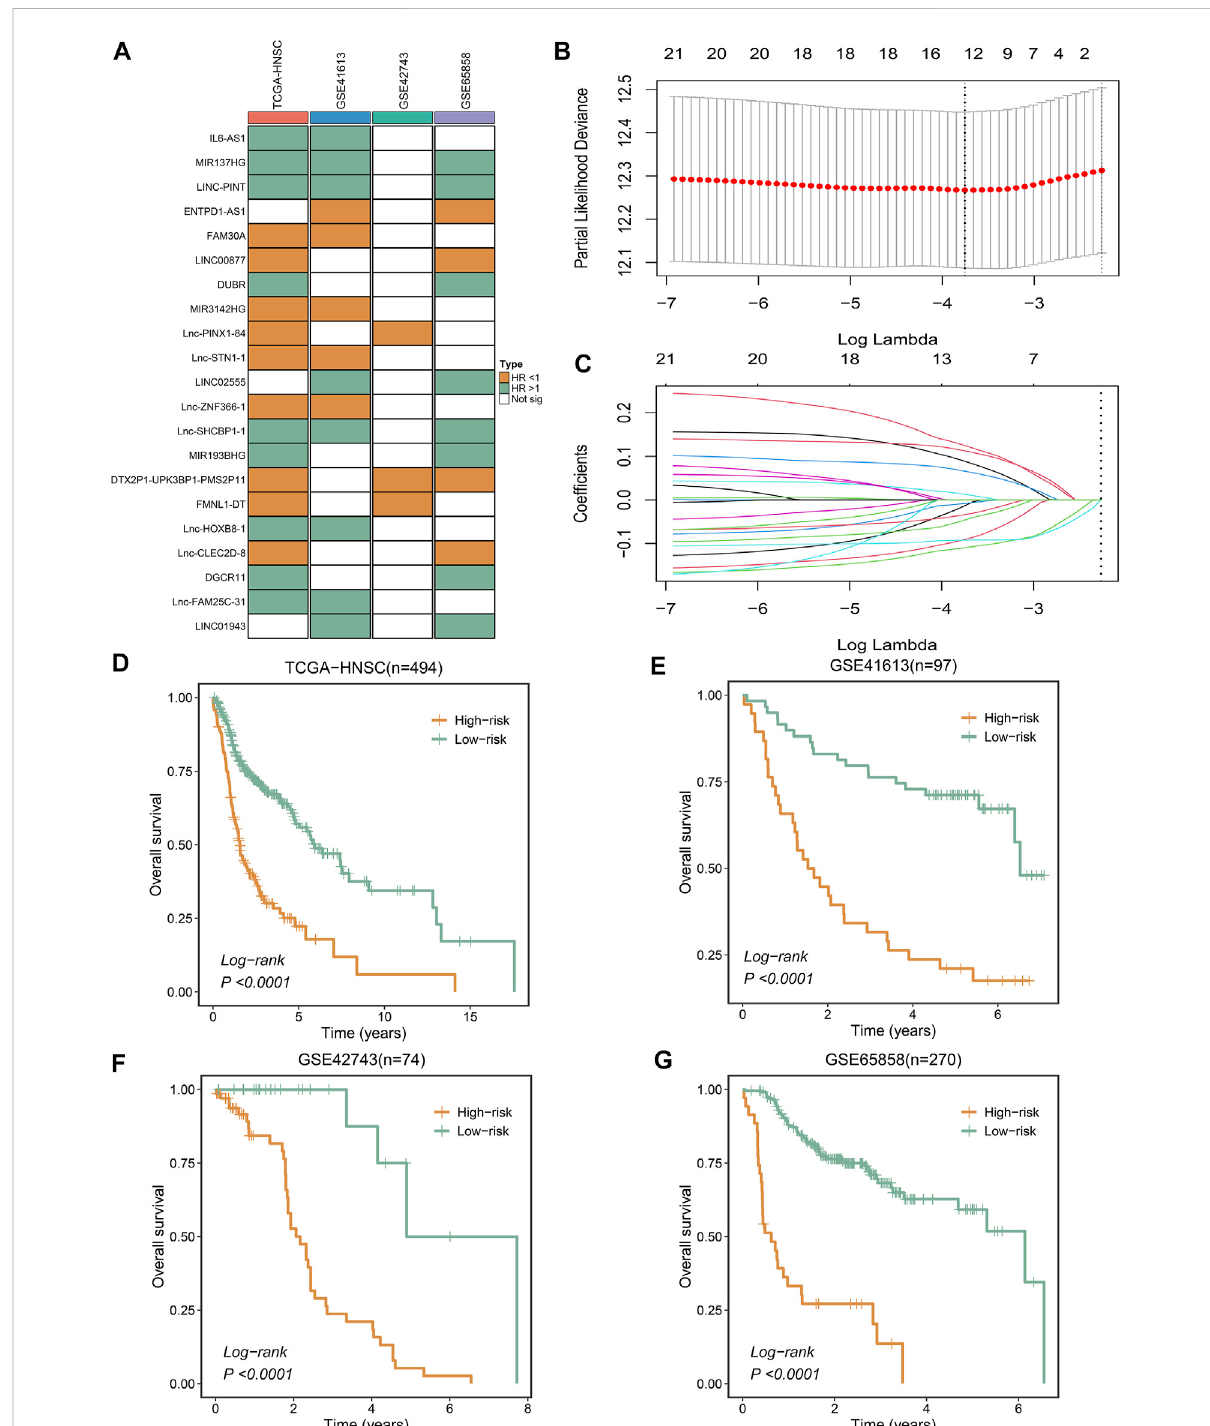
FIGURE 2 Integrative construction of a robust signature. (A) Discovery of 21 consensus prognosis genes from four independent multi-center cohorts. (B,C) Least absolute shrinkage and selection operator (LASSO) logistic regression algorithm to screen of gene associated with prognostic. (D – G) Kaplan – Meier curves of OS according to the NLPS in TCGA-HNSC (D) , GSE41613 (E) , GSE42743 (F) , GSE65858 (G)